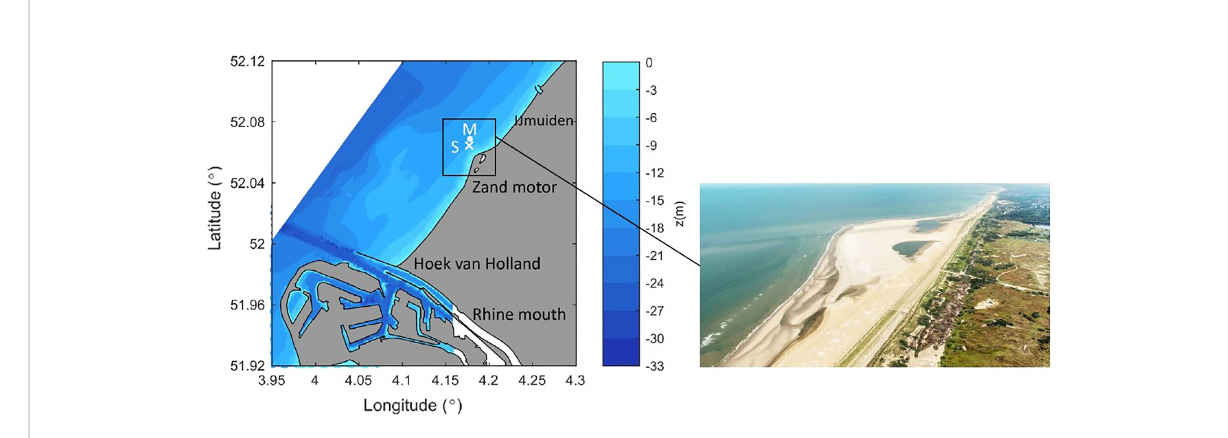
FIGURE 1 Left fi gure: Measurement position is given by (x), position of the survey vessel (S, cross), and the mooring and frames (M, dot). Right fi gure: Aerial view of the Sand Engine close to which the fi eld survey was conducted (Photo: